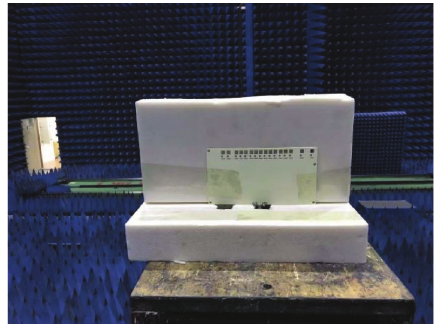
Figure 20: The measured